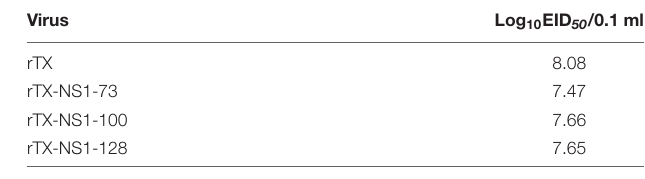
TABLE 1 | EID 50 of WT and NS-truncated viruses.